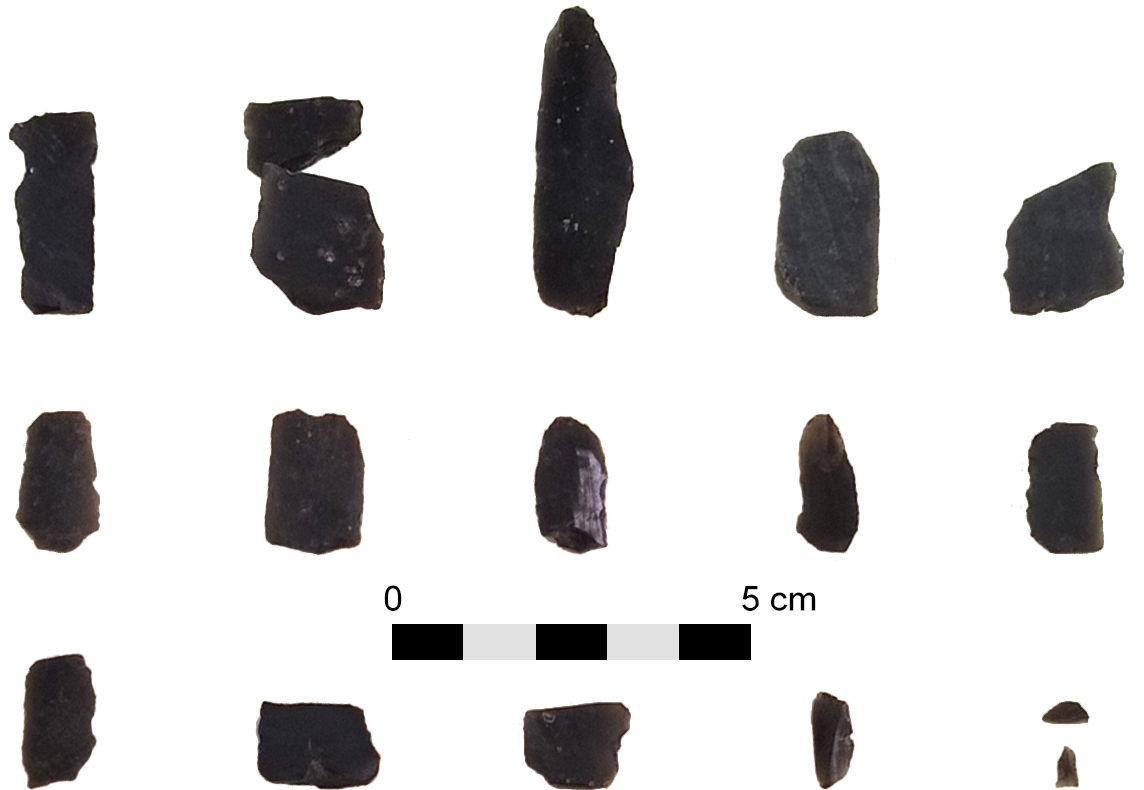
Figure 2: A sample of Lipari obsidian assemblages. The small assemblage found from surveys (Middle to Late Neolithic) at ‘Npisu and conserved at Sant’Angelo Muxaro, near Agrigento, Sicily. Despite the closer proximity with Pantelleria, and the presence of significant quantities of Pantelleria obsidian at some sites, just one of fourteen analyzed artifacts (last two bits were excluded) comes from Pantelleria: the second tool from the left in the last row.